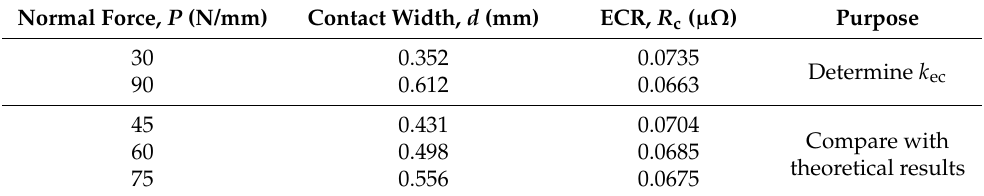
Table 3. Simulation results of contact width and ECR under different normal